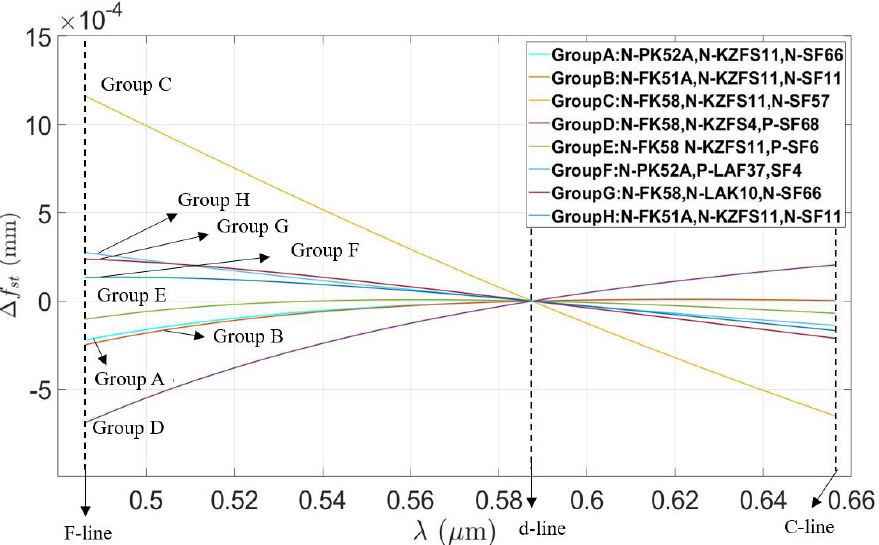
Figure 8. Optimized real lateral chromatic aberration curve for the eight triplet lens groups selected by the illustration